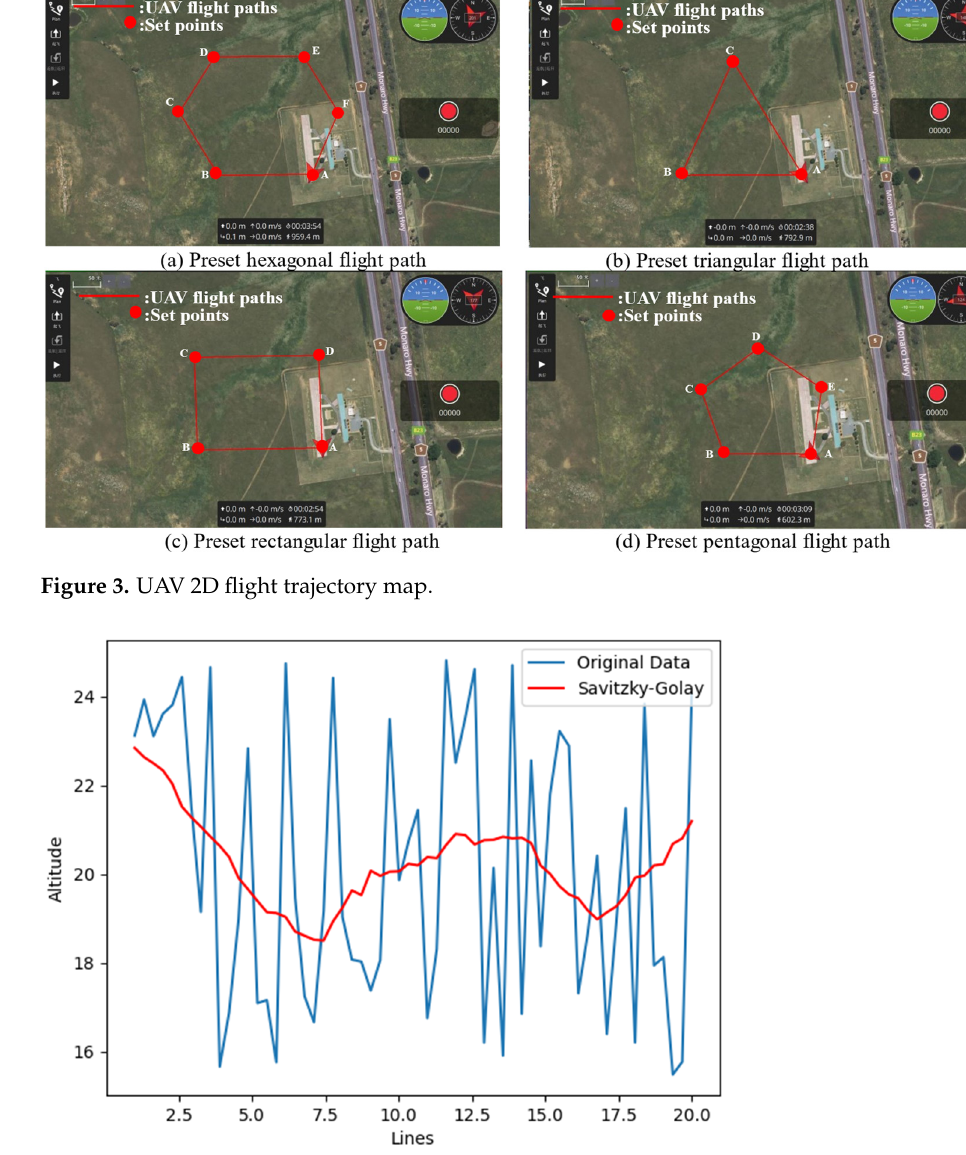
Figure 4. Altitude comparison of waypoints before and after using the Savitzky-Golay algorithm.